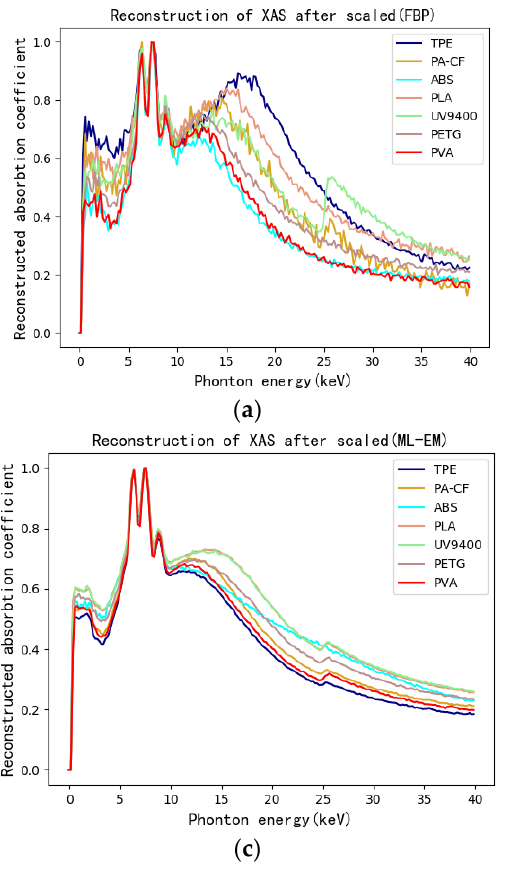
Figure 9. ( a ) Reconstructed XAS of ROI on the CT image of training-set specimen by FBP and ART ( b ) as well as ML-EM ( c )